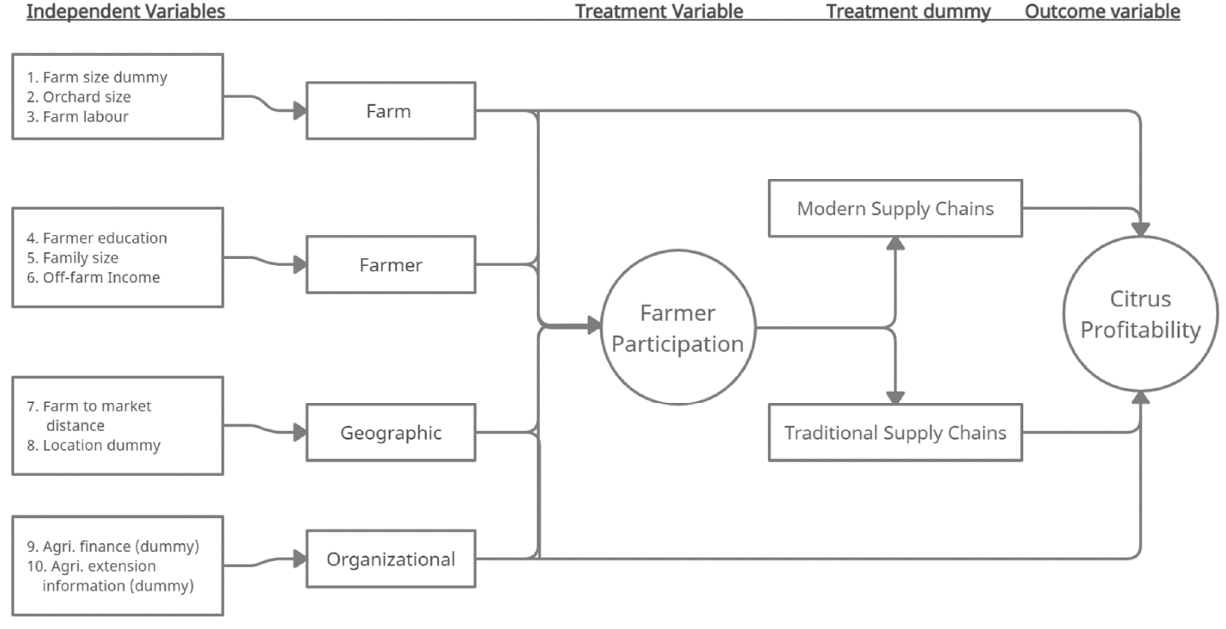
Figure 1. Framework for smallholders’ participation in agri-food supply chains. Source: Authors’ own illustration based on literature and field survey.